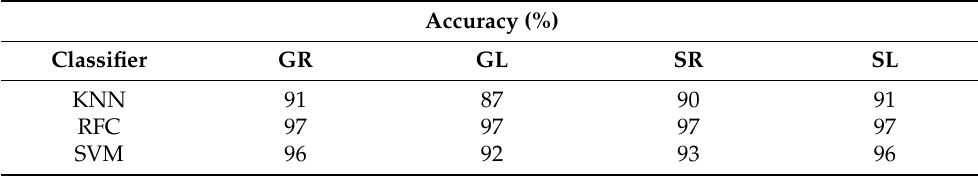
Table 4. Accuracy of operator’s overall discomfort classification using machine learning algorithms.